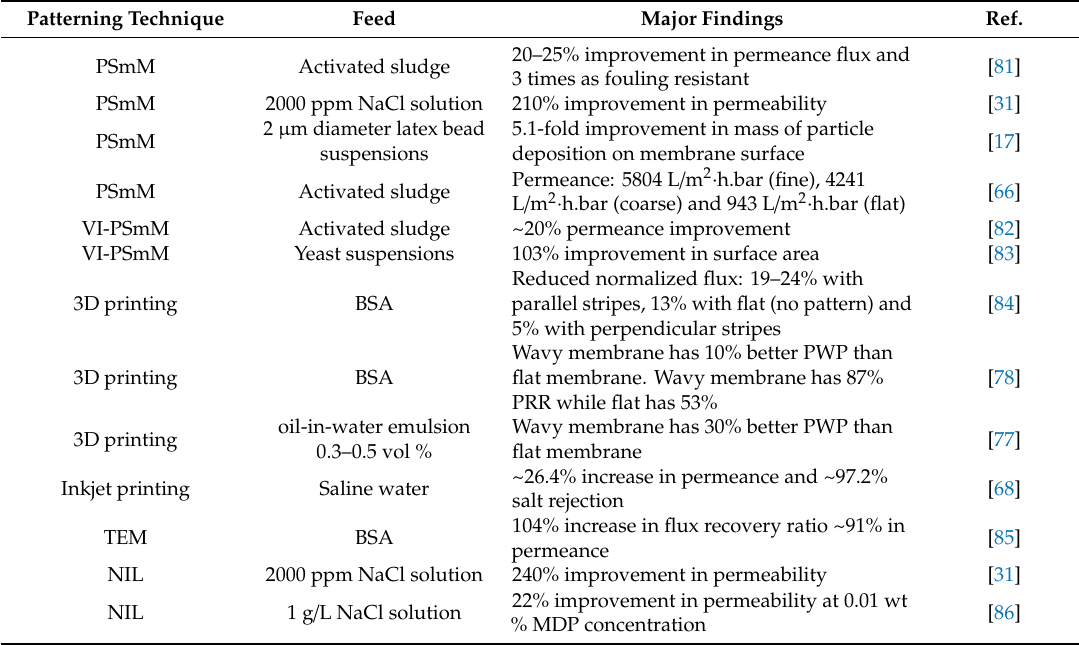
Figure 6. Illustration on the effect of flow orientation on membrane fouling propensity under ( a ) perpendicular flow direction and ( b ) under parallel flow direction. Table 2. Recent reports on performance of patterned membrane for water treatment.